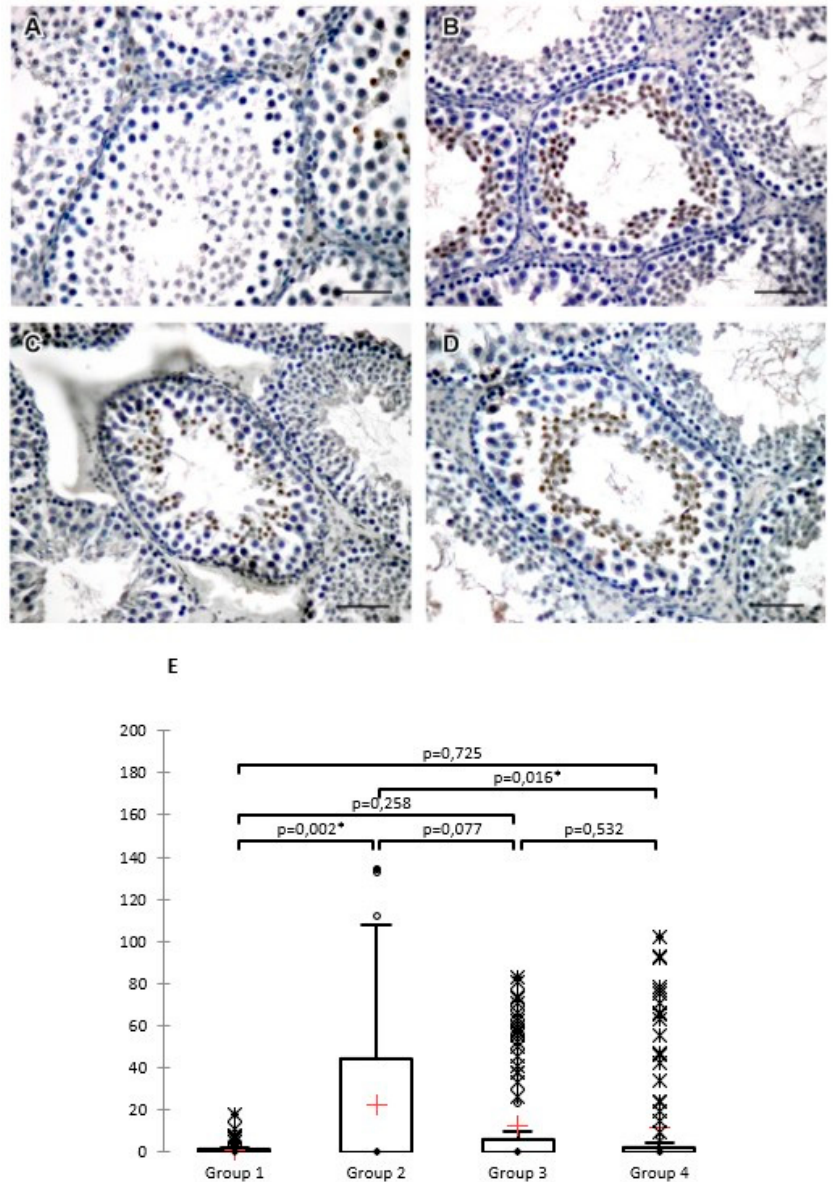
Figure 1. Caspase-3 positive cells on representative, randomly selected cross-sections on which the measurements were performed: ( A ) group 1, ( B ) group 2, ( C ) group 3, and ( D ) group 4. DAB, hematoxylin counterstain, scale bar 50 µm. ( E ) Box plots for caspase-3 positive cells (data are presented as mean ± SD). A Kruskal − Wallis test revealed a statistically significant difference in the number of caspase-3 positive cells between the different groups (at a significance level of 5%); ( χ 2 = 10.441 (7.815), DF = 3, p = 0.015), * p < 0.05.